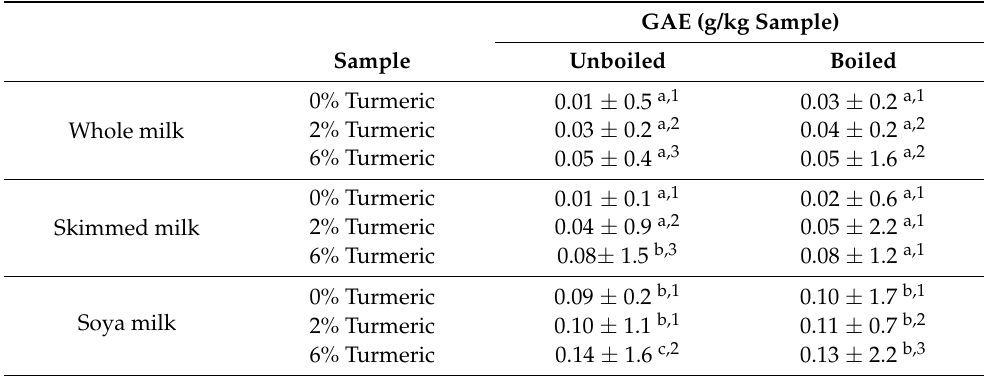
Table 1. Total phenolic compounds, expressed in milligrams of GAE per kg of whole milk, skimmed milk, and soya